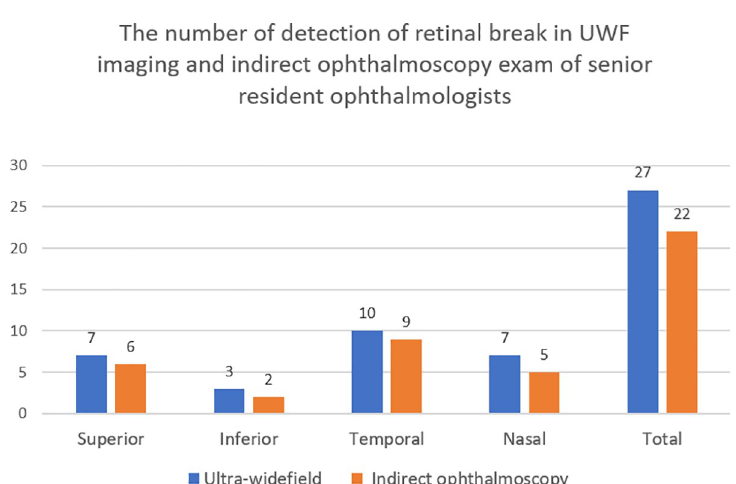
Fig 4. Number of retinal breaks detected by indirect ophthalmoscopy and UWF imaging examinations performed by senior resident ophthalmologists. For the indirect ophthalmoscopy examination, a total of 22 retinal breaks were detected in the 22 eyes; there were 6, 2, 9, and 5 retinal breaks detected in the superior, inferior, temporal, and nasal quadrants, respectively. For the UWF imaging, a total of 27 retinal breaks were detected in the 22 eyes; there were 7, 3, 10, and 7 retinal breaks detected in the superior, inferior, temporal, and nasal quadrants, respectively.